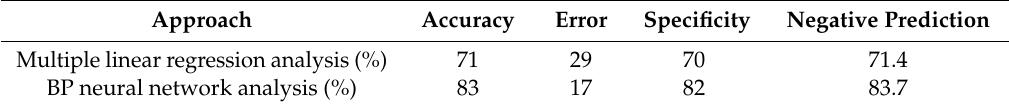
Table 8. Pitch failure model prediction performance index.